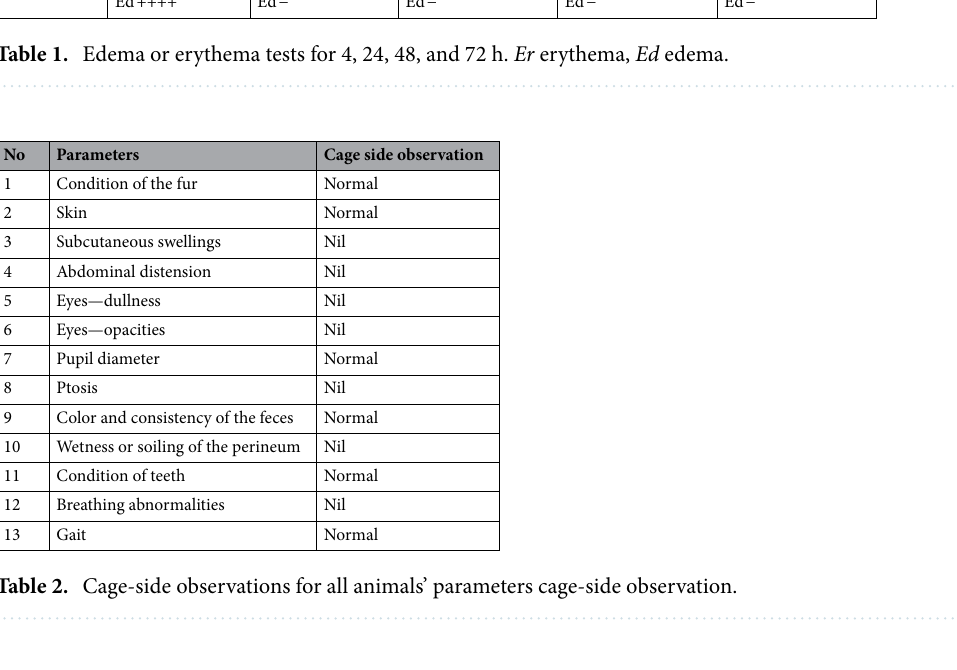
Table 1. Edema or erythema tests for 4, 24, 48, and 72 h. Er erythema, Ed edema.